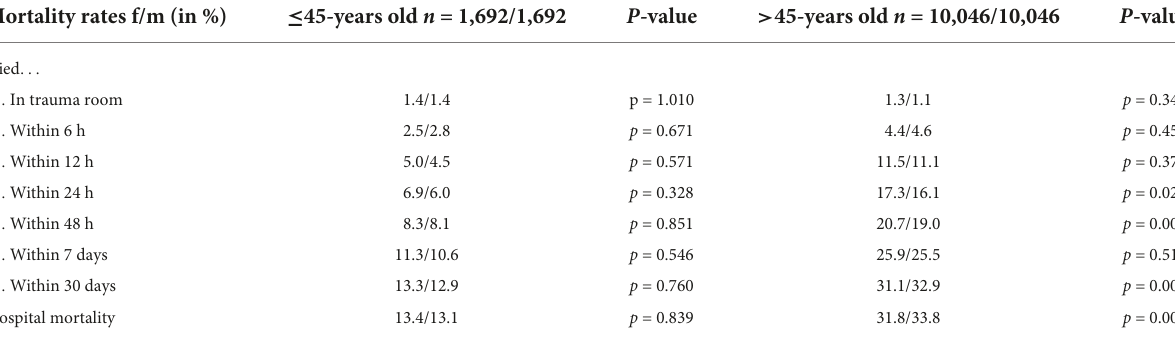
TABLE 5 Mortality rates shown in temporal distribution in the younger ( ≤ 45-years old) vs. the older population ( > 45-years old). Mortality rates f/m (in %) ≤ 45-years old n = 1,692/1,692 P -value > 45-years old n = 10,046/10,046 P -value Died